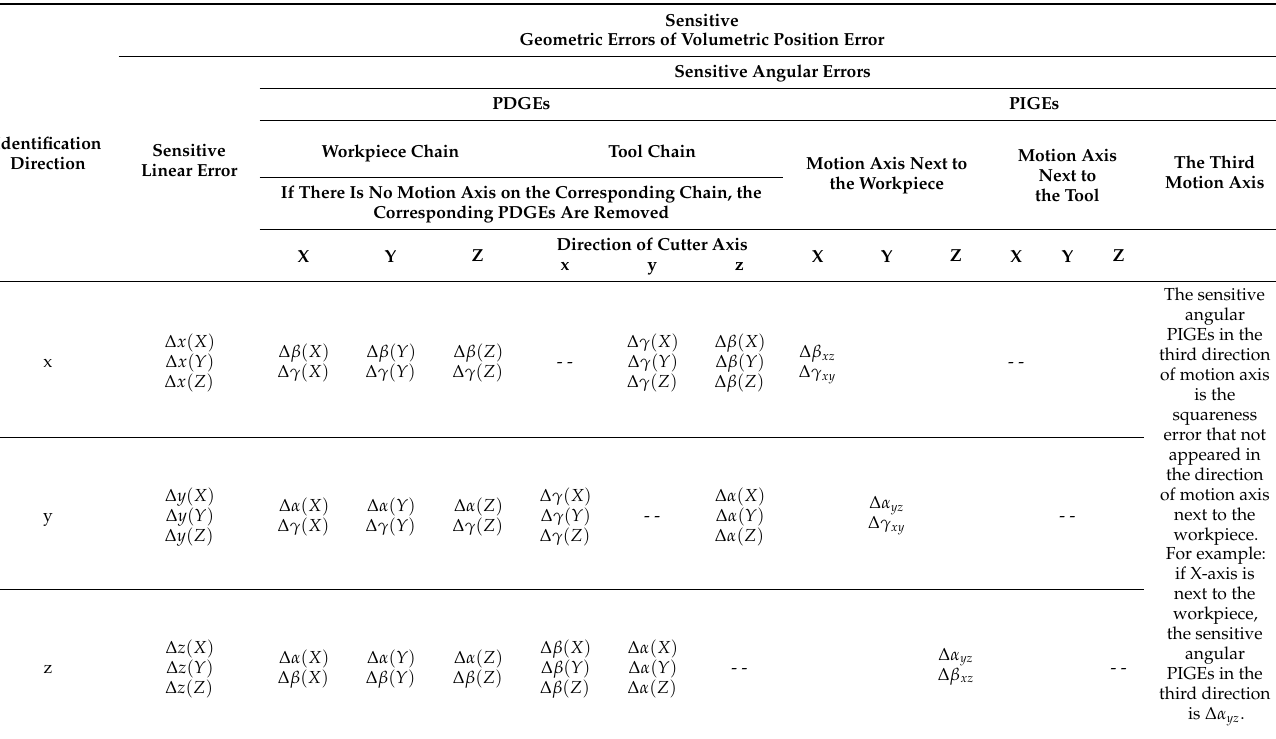
Table 2. Identification law of sensitive geometric errors of volumetric position